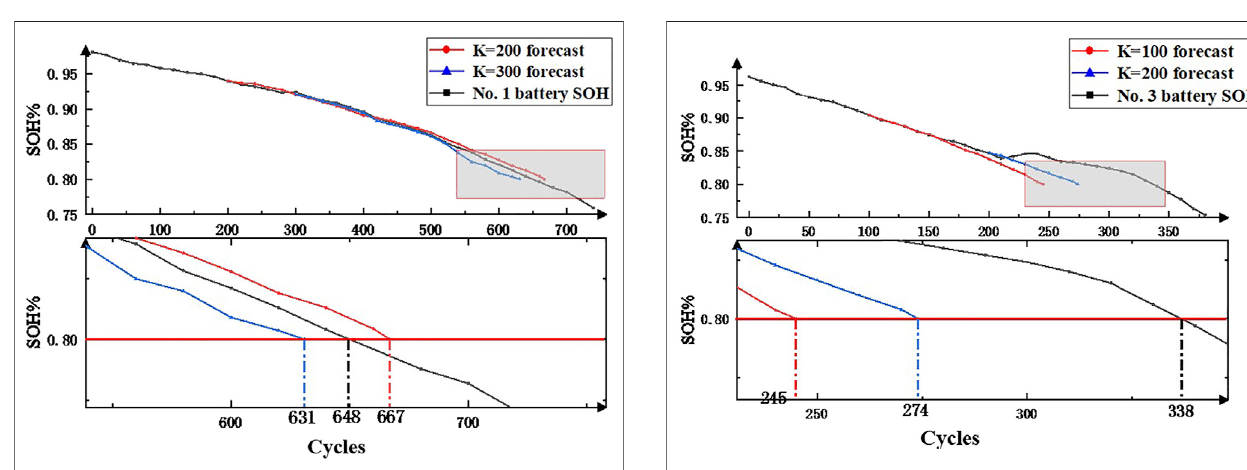
FIGURE 4 | Prediction results of the particle fi lter algorithm for No. 3 battery.